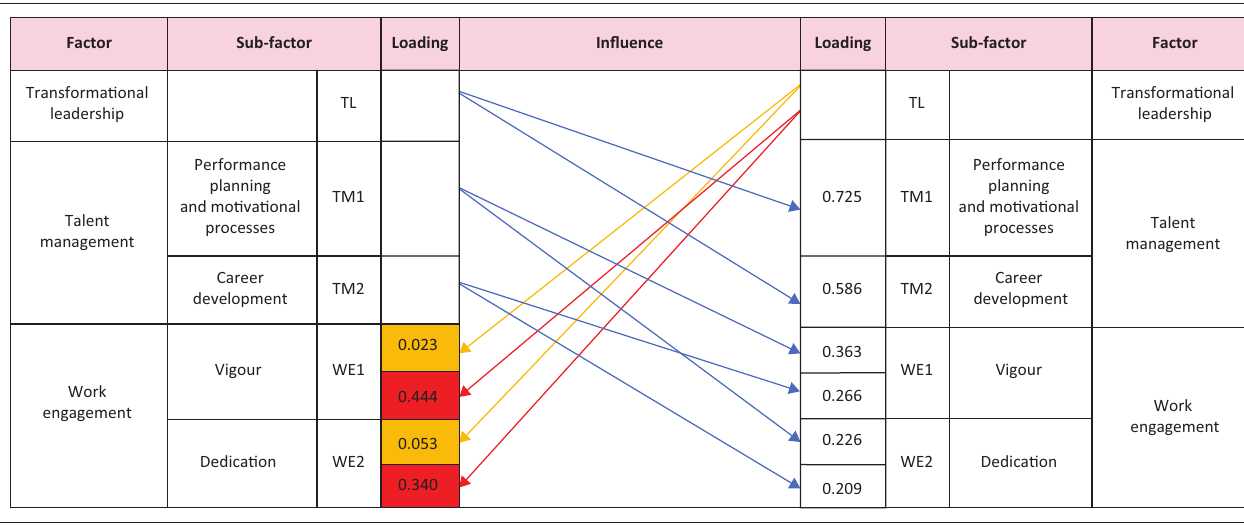
FIGURE 2 : The different paths of influence from statistical